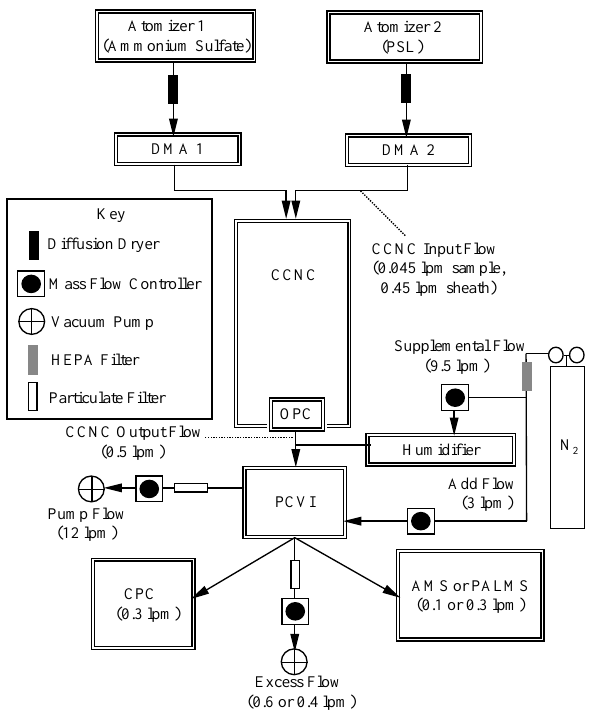
Fig. 1. Schematic of the experimental setup. The diffusion dryer ensured a relative humidity below 5% upon entry to the